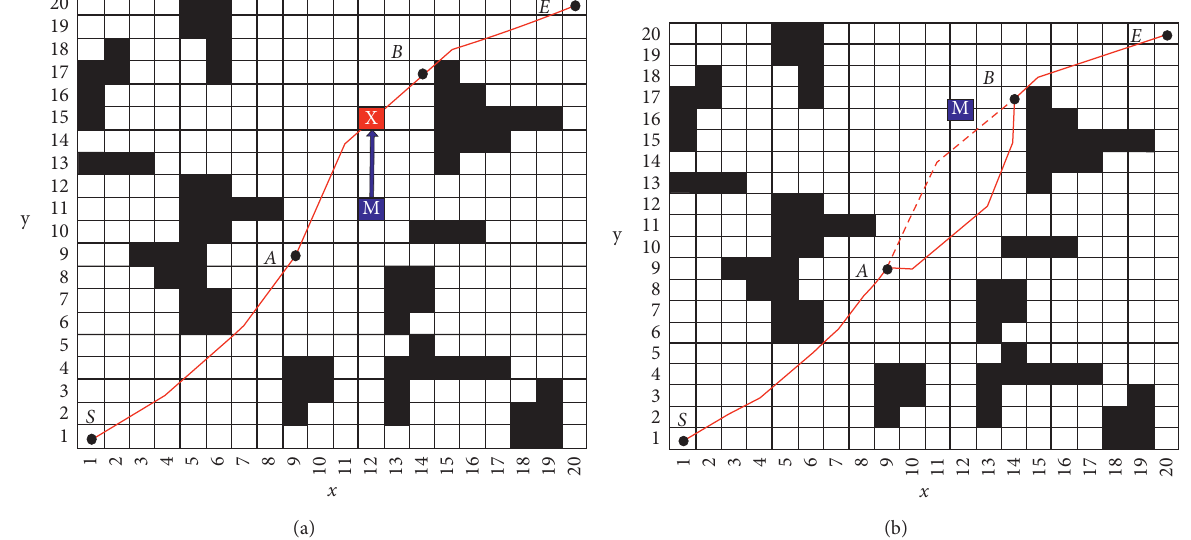
Figure 5: Dynamic obstacle avoidance: (a) the robot is located in A and (b) the robot is located in